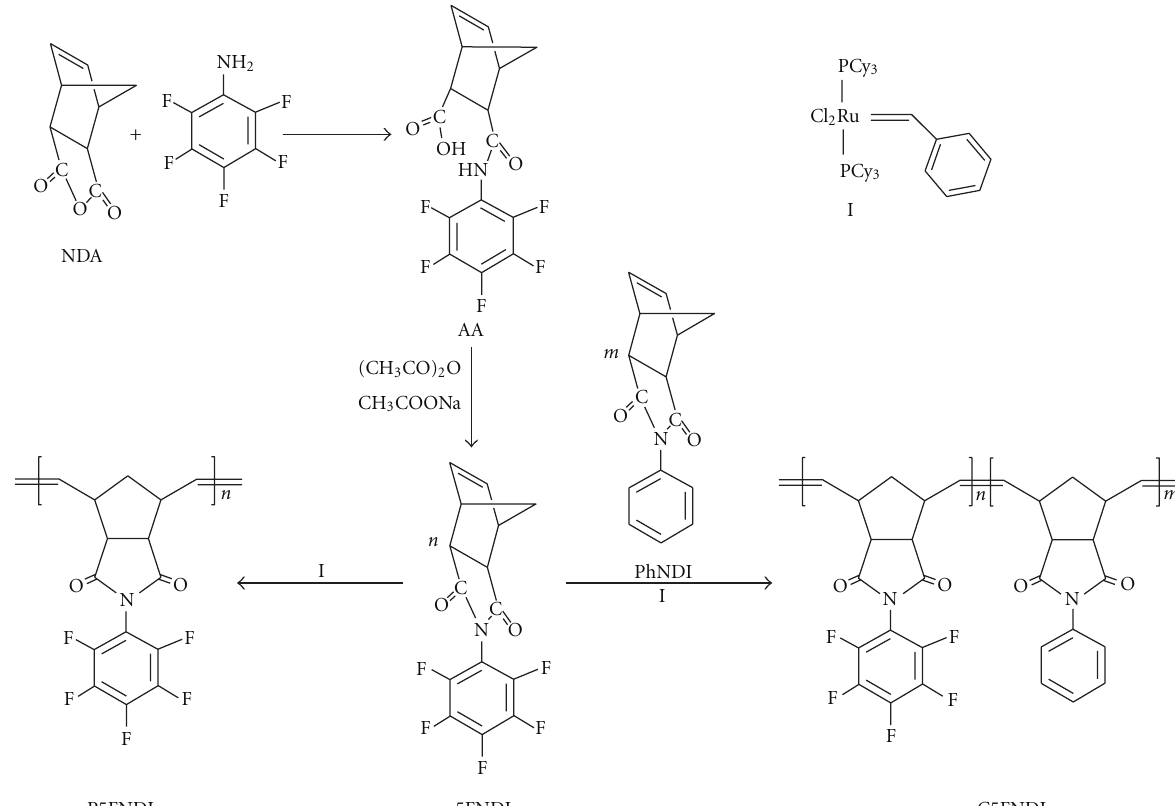
Scheme 1: Monomer synthesis and further